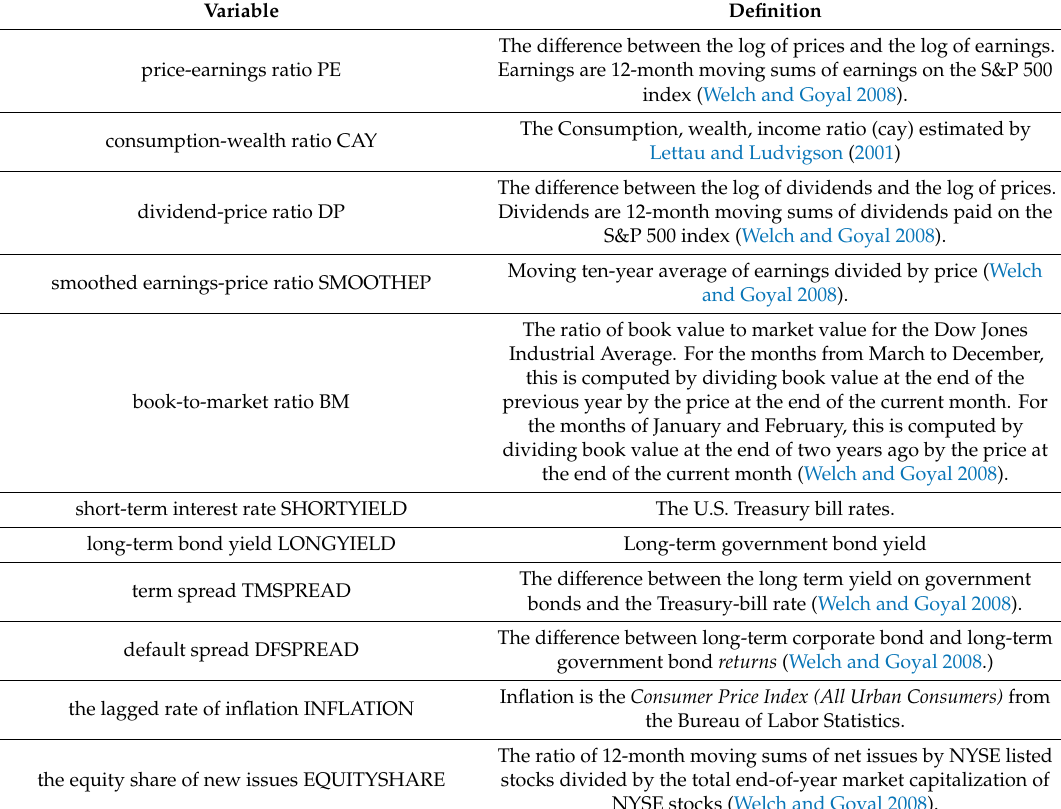
Table A1. Control Variable